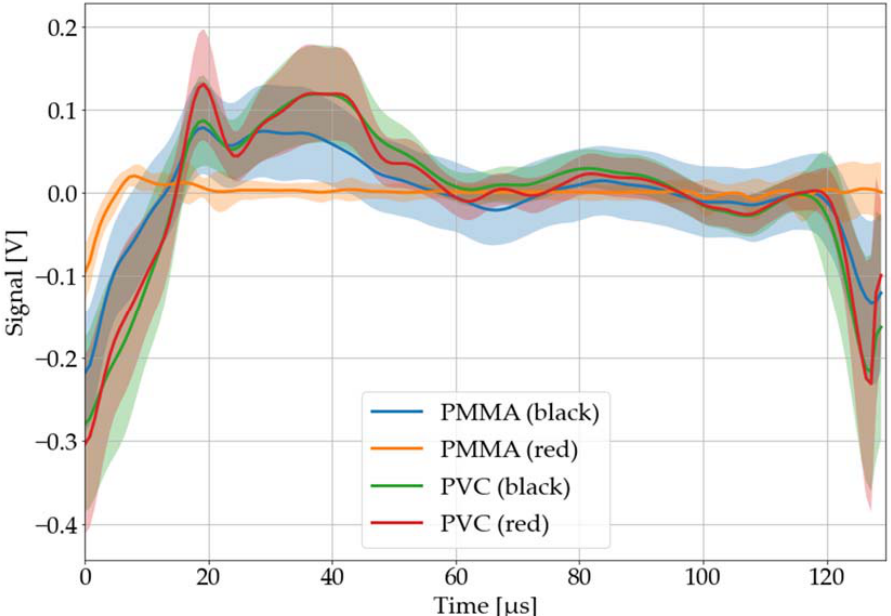
Figure 12. Recorded, processed, and averaged laser-acoustic responses for black and red PMMA and PVC. The colored area around each graph corresponds to its 68% confidence